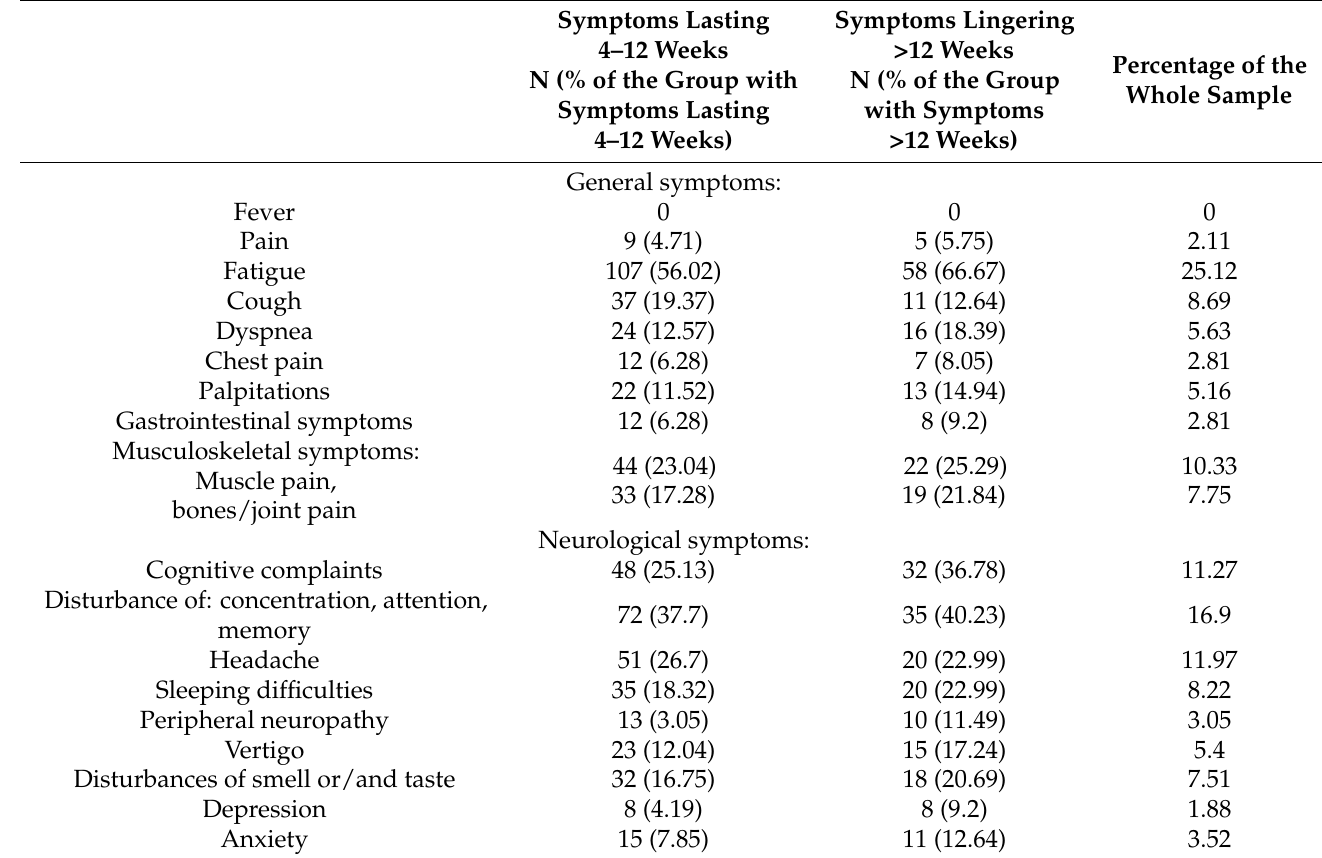
Table 2. Frequency of residual symptoms in the group of individuals with MS after SARS-CoV-2 infection.